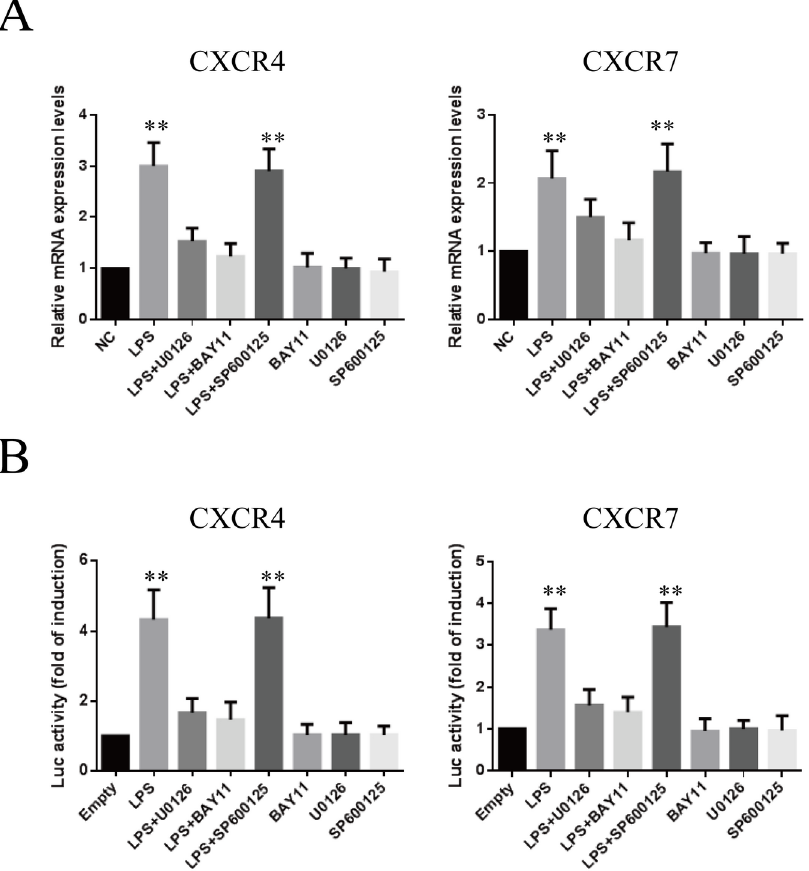
Fig 3. Effects of different inhibitors on LPS-induced CXCR4 and CXCR7 mRNA expression and promoter activity. (A) Cells were pretreated with inhibitors specific for JNK (SP600125), ERK1/2 (U0126), and NF- κ B (BAY 11 – 7082) at 10 μ M concentrations for 1 h and then with LPS (1 μ g/ml) for 24 h; CXCR4 and CXCR7 mRNA levels were determined by real-time PCR. (B) Luciferase activity of CXCR4 and CXCR7 promoter constructs transiently transfected into RF/6A cells and then pretreated with SP600125 (10 μ M), U0126 (10 μ M) or BAY 11 – 7082 (10 μ M) for 1 h, followed by treatment with or without LPS (1 μ g/ml) for an additional 24 h. The results are expressed as fold changes of luciferase activity (relative light units, RLUs), compared to the group without LPS treatment ( ** P < 0.01). Data are mean ± SD for four independent